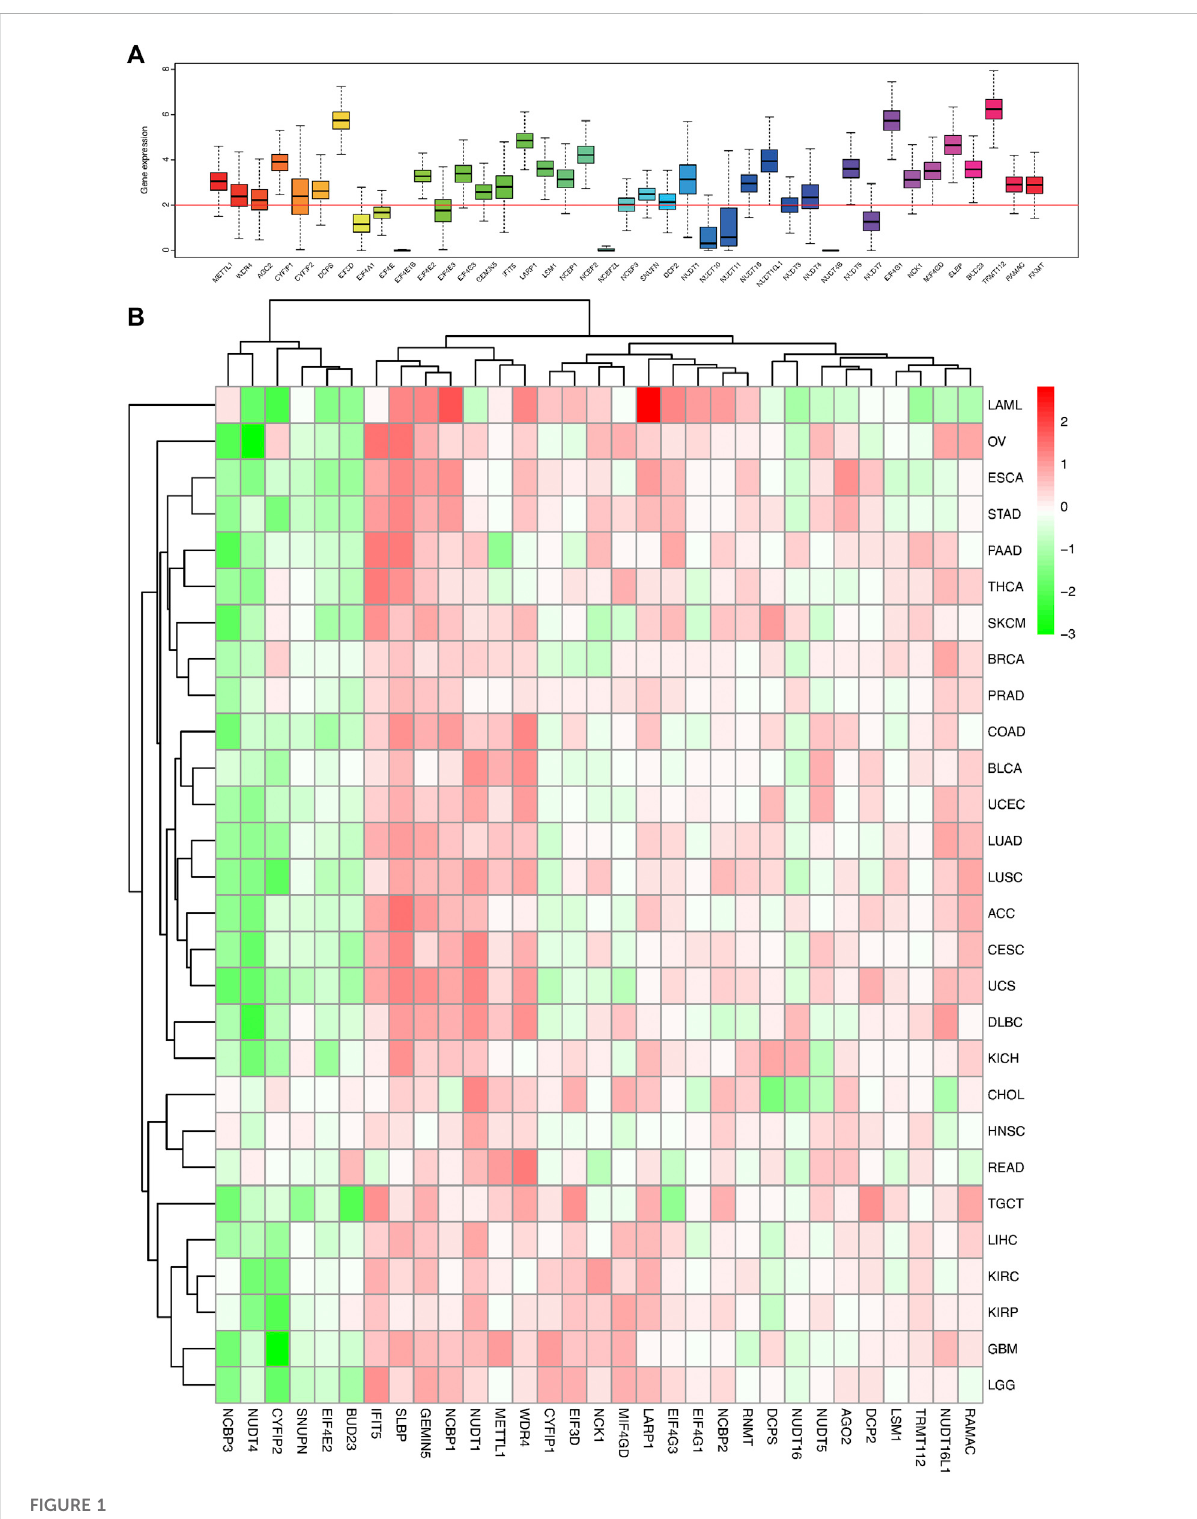
FIGURE 1 Box plot and heat map of the differential expression of 41 m7G regulators in 18 cancer types. (A) Box plot showing the expression of 41 m7G regulators in 18 TCGA cancer tissues. (B) Heat map showing the differential expression of 31 m7G regulators across 18 cancer